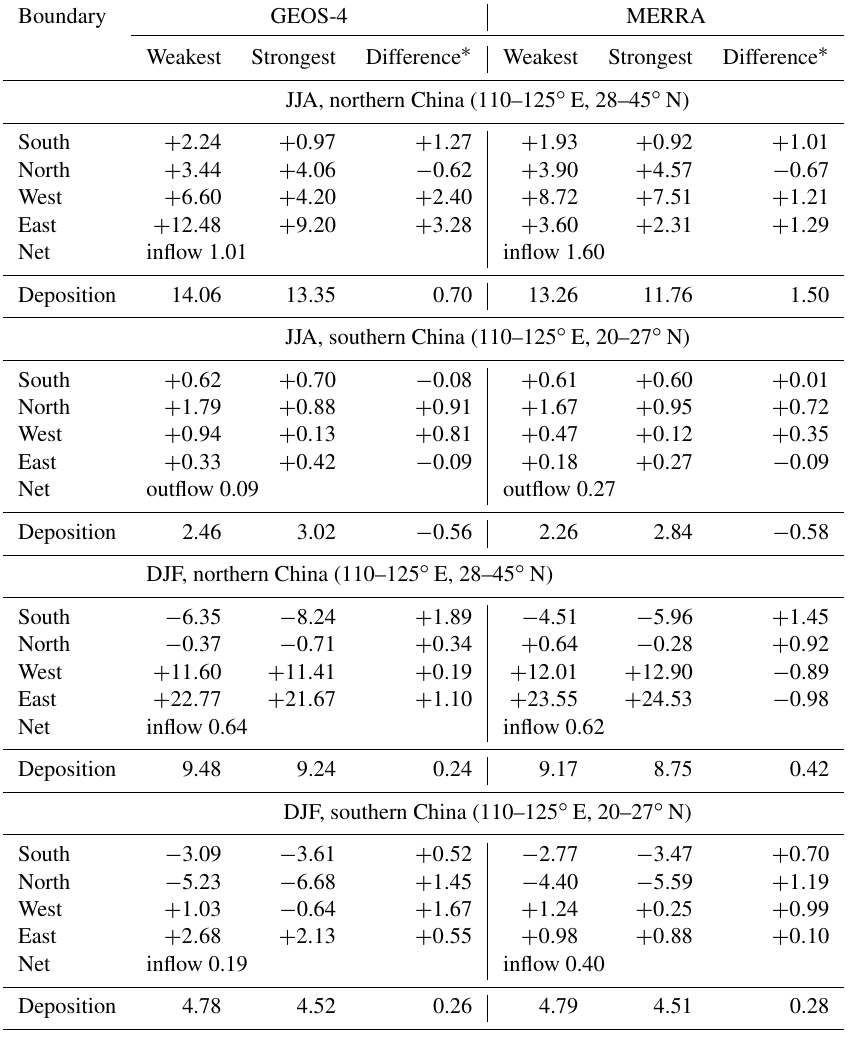
Table 3. The composite analyses of JJA (DJF) horizontal fluxes of BC (kgs − 1 ) for two selected boxes (northern China (110–125 ◦ E, 28– 45 ◦ N) and southern China (110–125 ◦ E, 20–27 ◦ N), from the surface to 10km) based on simulations VMETG4 and VMET. The values are averages over the 5 weakest and 5 strongest EASM (EAWM) years during 1986–2006. For horizontal fluxes, positive values indicate eastward or northward transport and negative values indicate westward or southward transport. Also shown are the corresponding wet deposition of BC (kgs − 1 ) for the two selected